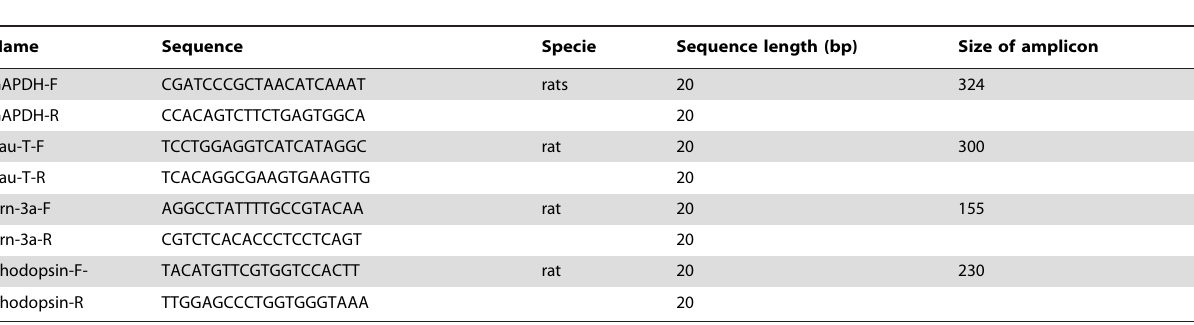
Table 1. Primer sequences used in PCR and qPCR